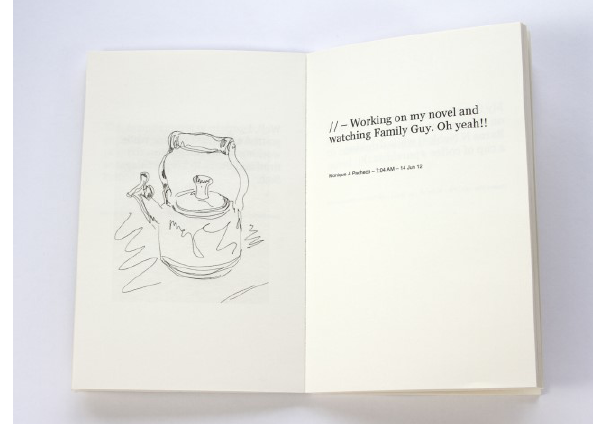
Figure 7 | Cory Arcangel, Working On My Novel (2014), paperback, 144 pages, published by Penguin Books